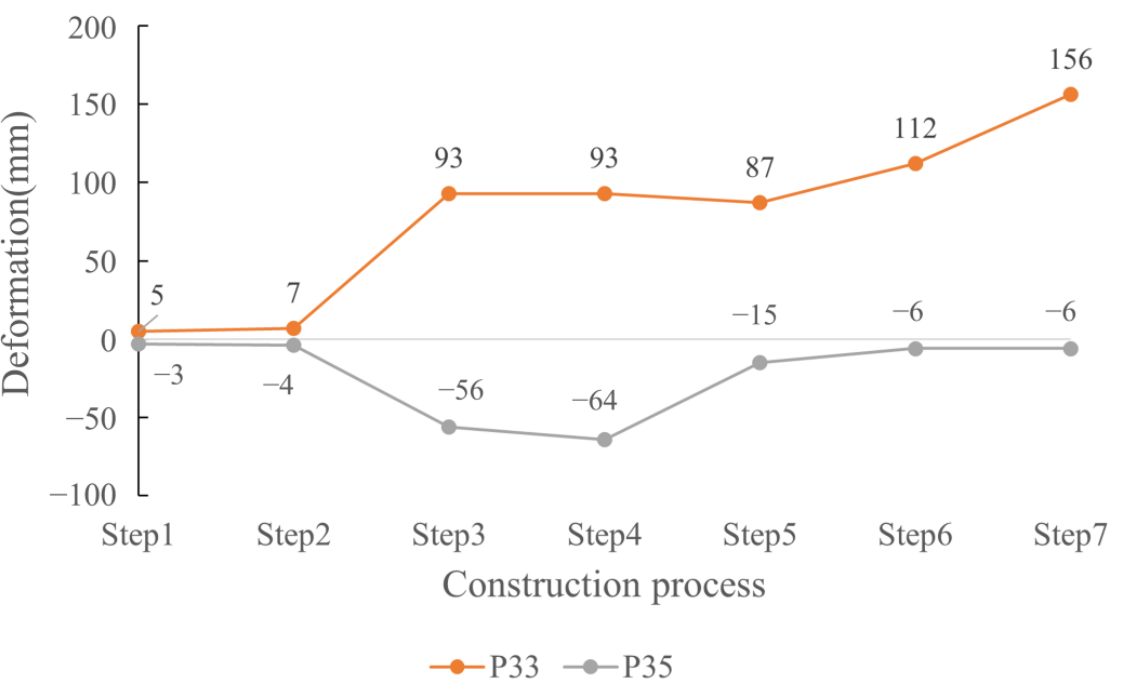
Figure 15. The longitudinal inclination of the pier.